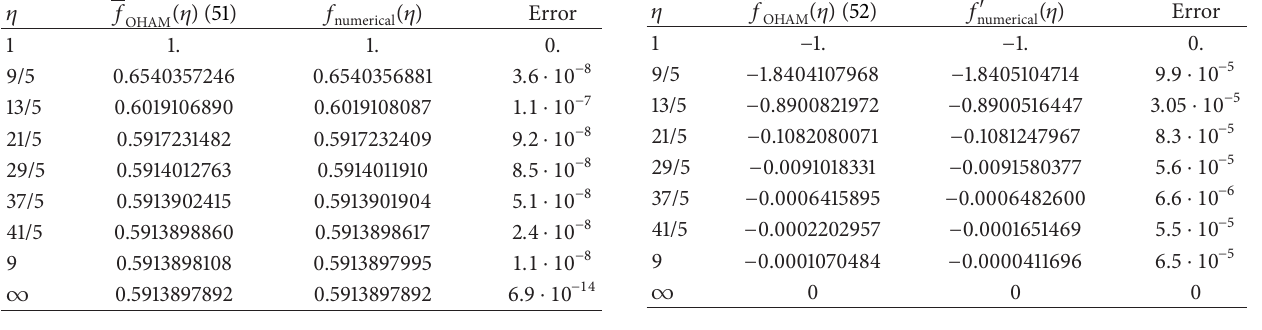
󸀠 (𝜂) obtained from 󸀠 (𝜂)− OHAM